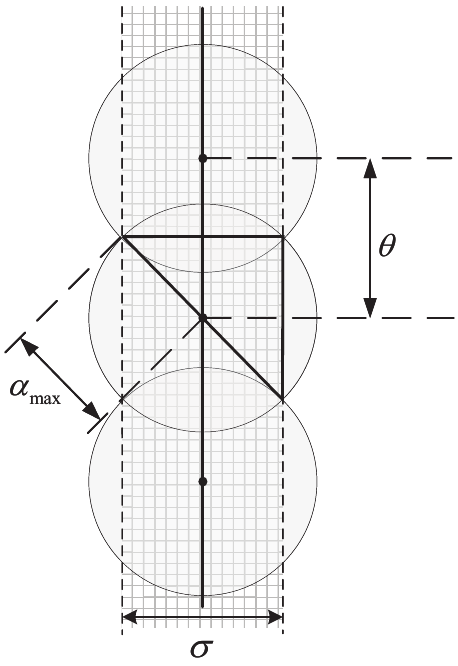
Figure 2. Street-of-coverage geometry of one orbital plane. Since mega Walker constellation satellites are located at the same inclination, the SOC of adjacent orbital planes are approximately parallel to each other at low latitudes, shown in Figure 3. If the SOC of adjacent orbital planes could overlap with each other, continuous coverage can be achieved at low latitudes. It is noted that adjacent orbital planes could be co-rotating planes or counter-rotating planes, where satellites in the co- rotating planes move in the same direction ( ∆Ω is close to zero), while satellites in the counter-rotating planes move in the opposite direction ( ∆Ω is close to π ). Therefore, the relative motion relationships between co-rotating satellites are relatively fixed compared to counter-rotating satellites. From the perspective of self-organization, the adjacent orbital planes in the coverage constraint are specified as co-rotating planes.